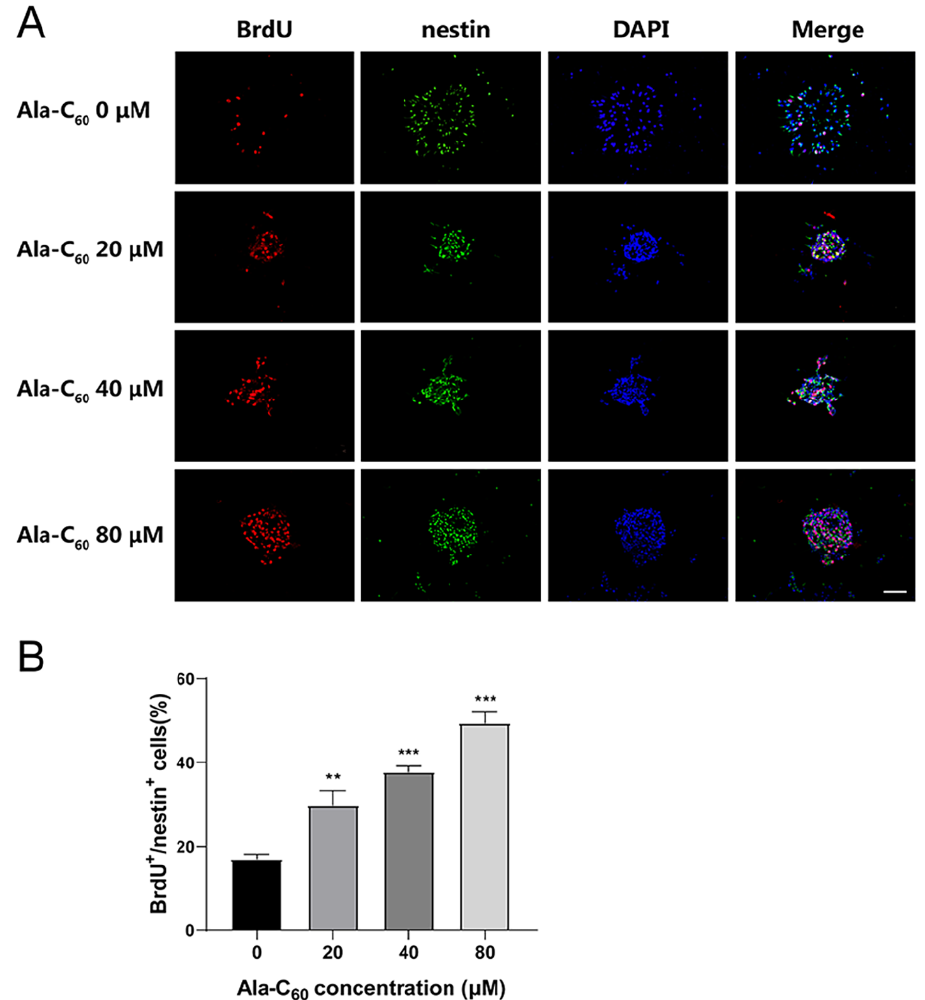
Figure 3. The effect of Ala-C 60 on the proliferation of cultured NSCs. ( A ) BrdU (red)/nestin (green)- positive cells were identified via immunohistochemical staining. DAPI (blue) was used to label the nuclei. Scale bar = 100 µ m. ( B ) Quantitative analysis of BrdU/nestin-positive cells. ** p < 0.01, *** p < 0.001 according to ANOVA followed by LSD post hoc analysis.